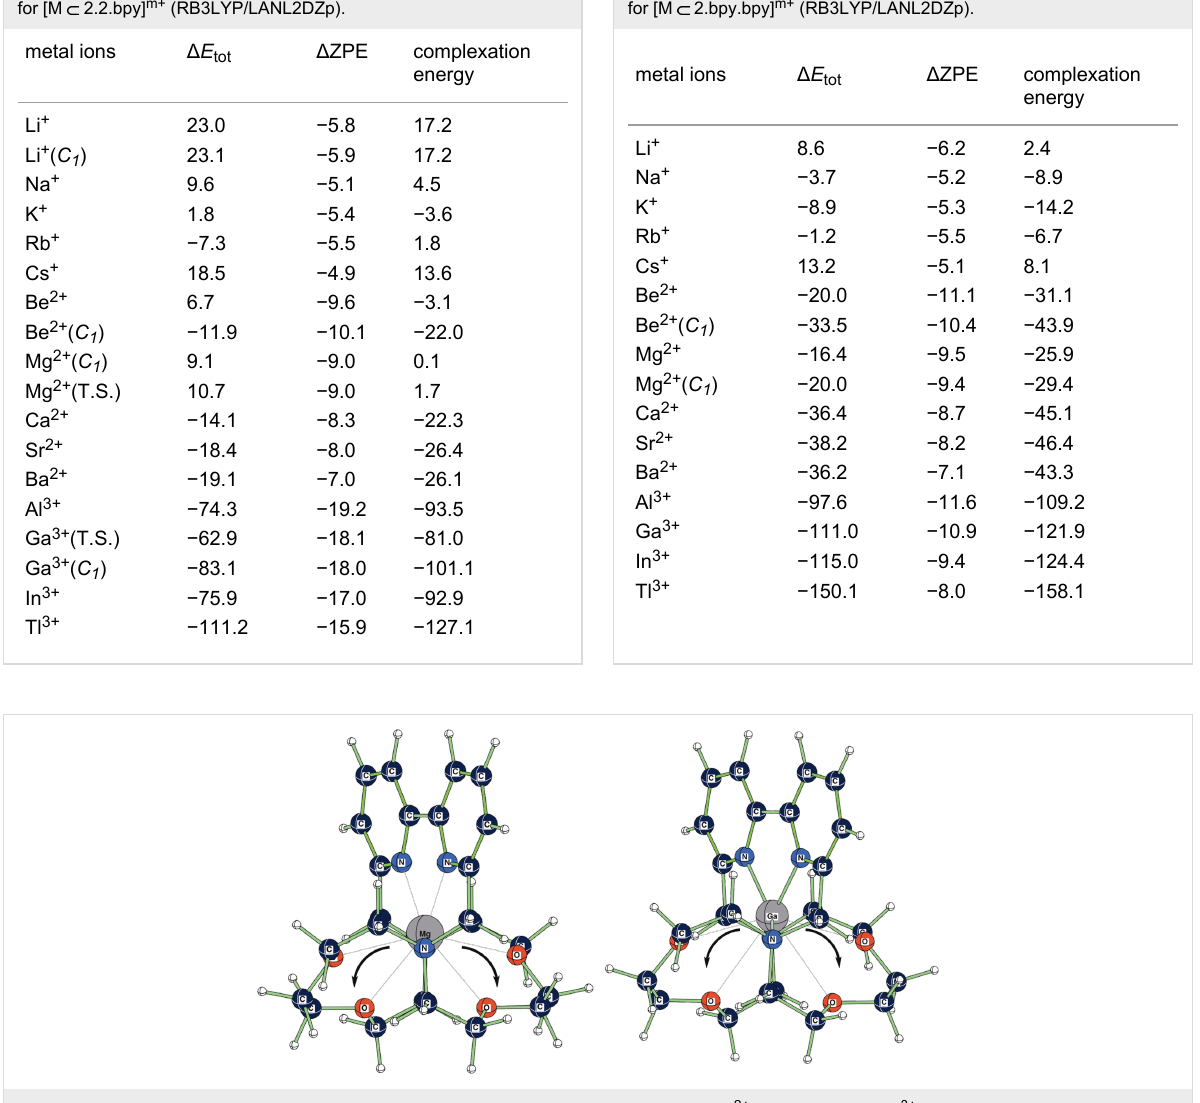
Figure 5: Calculated (RB3LYP/LANL2DZp) transition state structures ( C 2 ) for [Mg 2.2.bpy] 2+ and [Ga 2.2.bpy] 3+ , showing the displacement vector for the imaginary frequency.